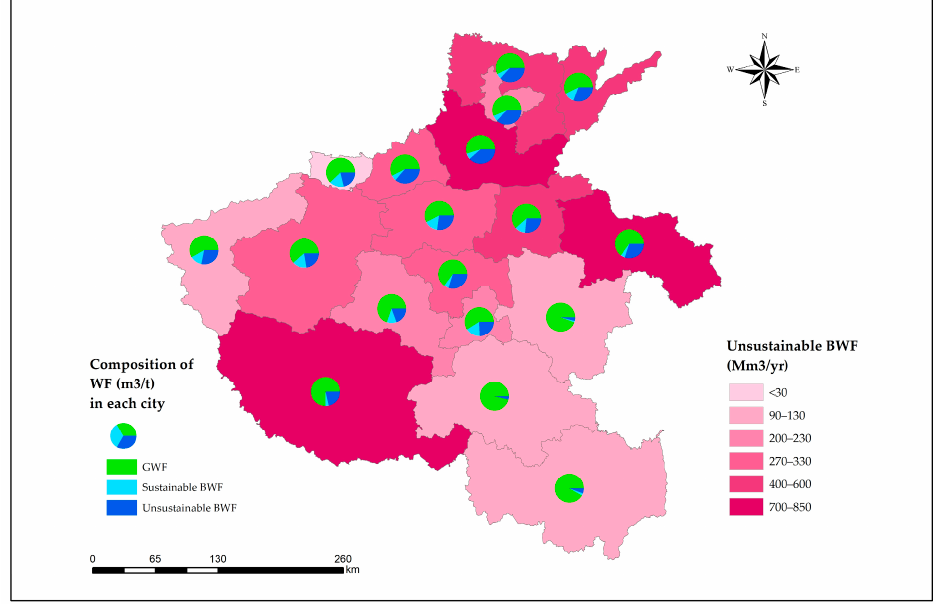
Figure 3. The distribution of unsustainable blue WF (Mm 3 /year) of wheat and the composition of WF (m 3 /t) in each city.